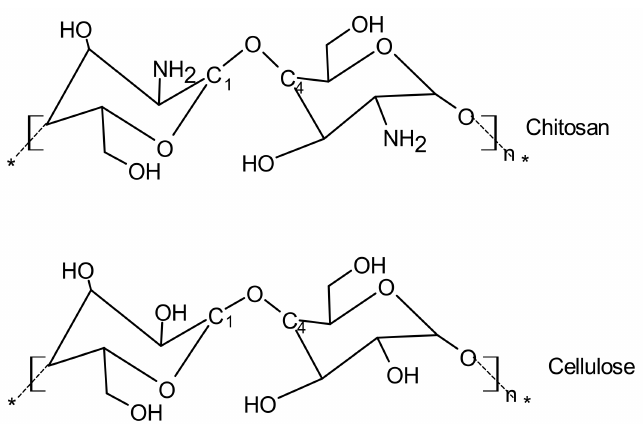
Figure 4. Chemical structure of chitosan and cellulose. Reprinted from Omari et al. [61] with permission Royal Society of Chemistry provided by Copyright Clearance